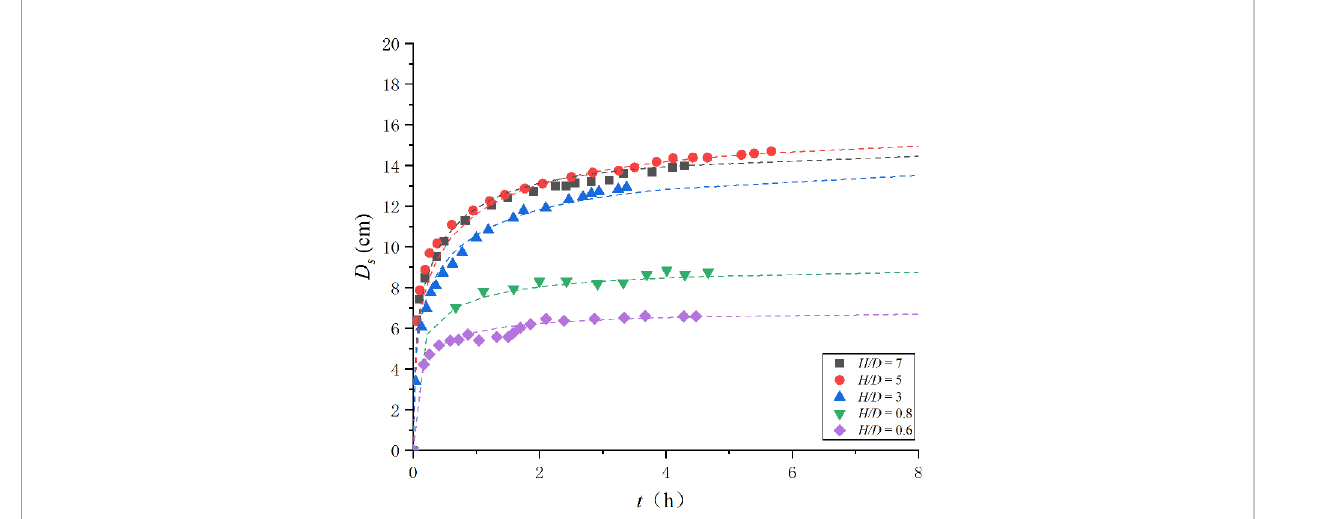
FIGURE 4 | Variation of scouring depth with time (symbols, experimental data of Yao et al. (2018); dashed lines, fi tting curve by Eq. 30~31).